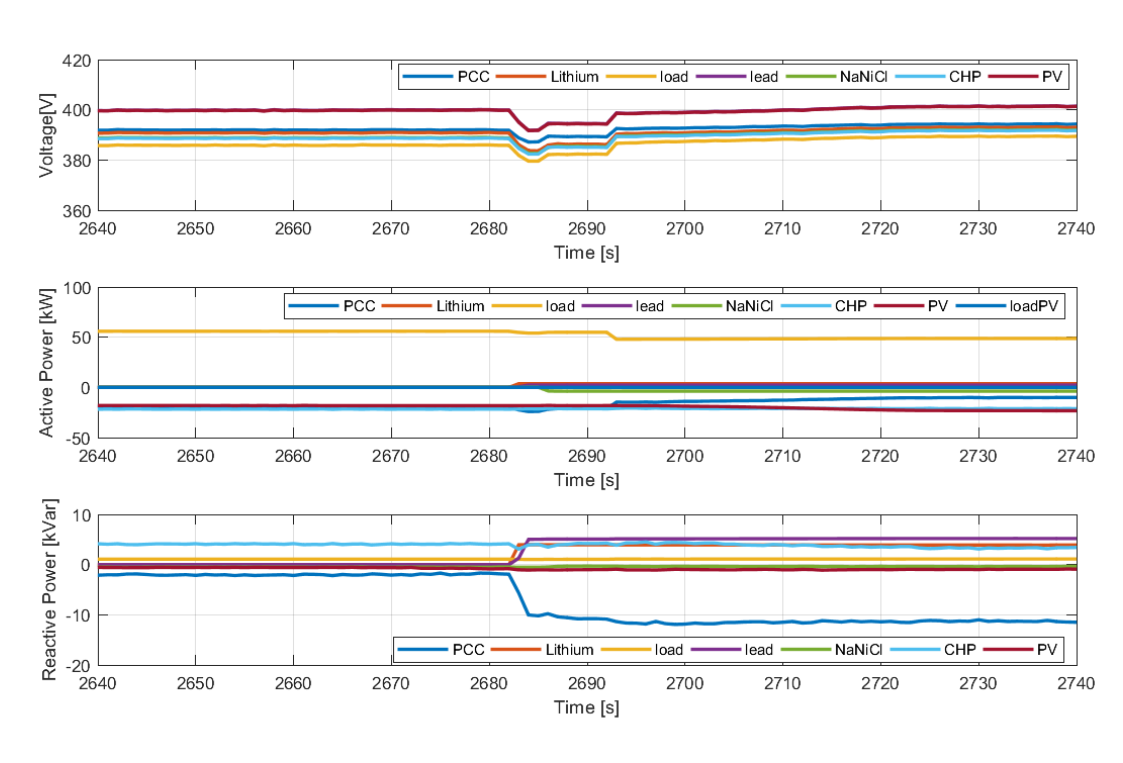
Figure 9. Voltage magnitudes in test system over time and active and reactive power outputs in overvoltage condition and with the active and reactive power control of all the resources in during islanded